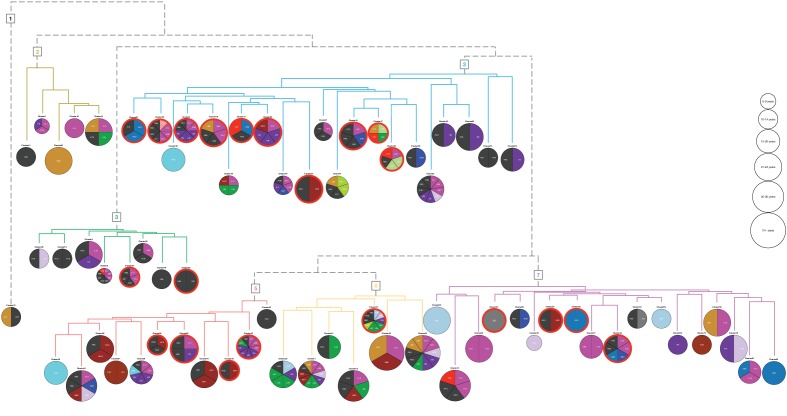
Hierarchical clustering based on enriched comorbid ICD-10 diagnoses.The comorbidities present in a minimum of 10 patients and significantly enriched (adj. p-value<=0.05) in each cluster are shown in the pie charts. The number of significant codes ranges from 1 to 10. Each color corresponds to an ICD-10 code chapter as listed in the legend of Figure 1. Six main groups and an outlier (cluster 70) resulted, and the colors of the dendrogram branches indicate to which hierarchical groups the clusters belong. The size of the pie charts represents the average diabetes duration (years with diabetes) divided into six bins. The 21 clusters where at least 50% of the patients have three or more HbA1c severity parameters are marked with a red line surrounding the pie chart.